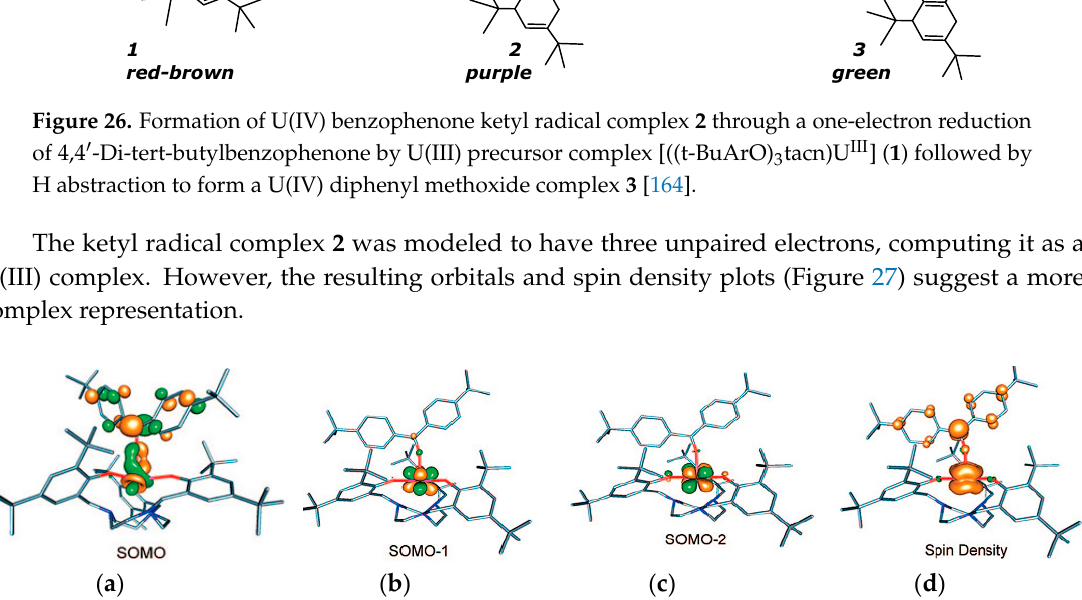
Figure 27. DFT isosurface contour plots featuring frontier SOMOs and spin density of the ketyl [(( tBu ArO) 3 tacn)U IV (OC · tBu Ph 2 )] complex ( 2 ). ( a ) SOMO; ( b ) SOMO-1; ( c ) SOMO-2; ( d ) Spin density. (Reprinted with permission from [164], American Chemical Society,